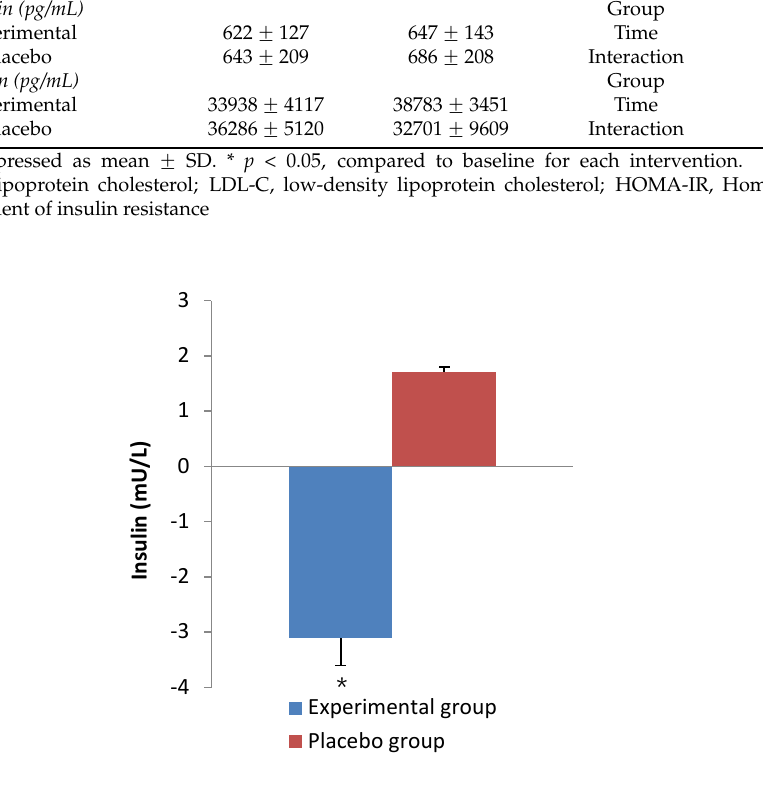
Figure 3. Change in insulin over the intervention period. Values are expressed as mean ± SEM. * p < 0.05, compared with placebo group.